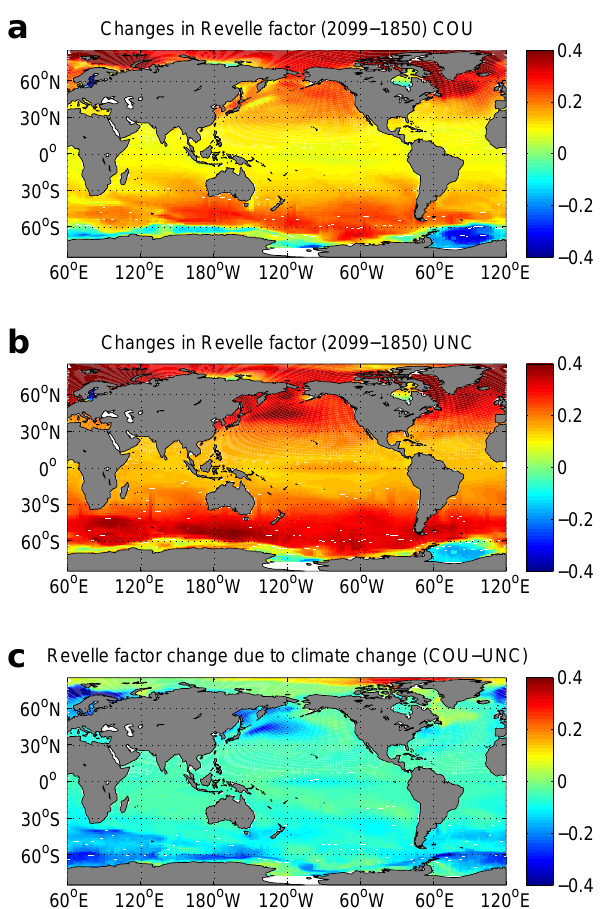
Fig. 13. Difference in Revelle factors between year 2099 and 1850 simulated in the (a) COU and (b) UNC simulations, and (c) COU minus UNC for year